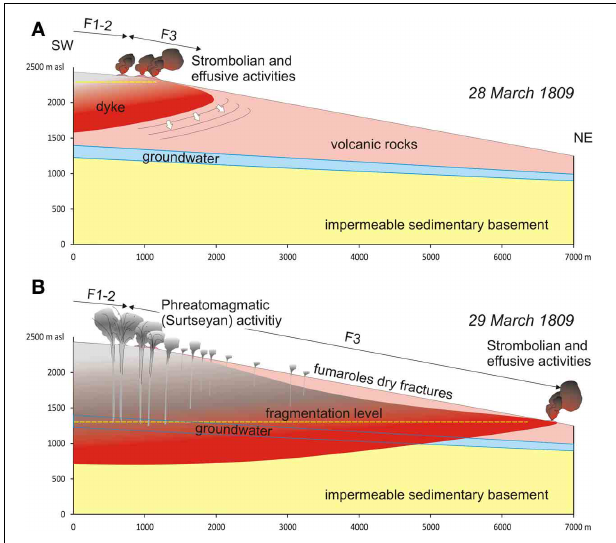
FIGURE 12 | Model of dyke propagation of the 1809 eruption, between 2500 and 1300m asl. On 28 March, the dyke from the Central Crater ( ∼ 3200m asl) propagates downslope (A) , erupting at the lower portion of the fracture field (F1–3); at this stage the dyke is too shallow to involve the groundwater. On 29 March, the dyke propagates downslope reaching a minimum elevation of 1450–1325m asl (B) , where a new explosive and effusive vent formed. During the propagation, the dyke became deeper and magma interacted with the groundwater when the fragmentation level was roughly at the same elevation as the aquifer, generating phreatomagmatic (Surtseyan) activity along the higher portion of Fissure 3. It cannot be excluded that other shallower aquifers interacted with the dyke during its deepening and propagation downward. The position of the impermeable sedimentary basement is modified from Siniscalchi et al.